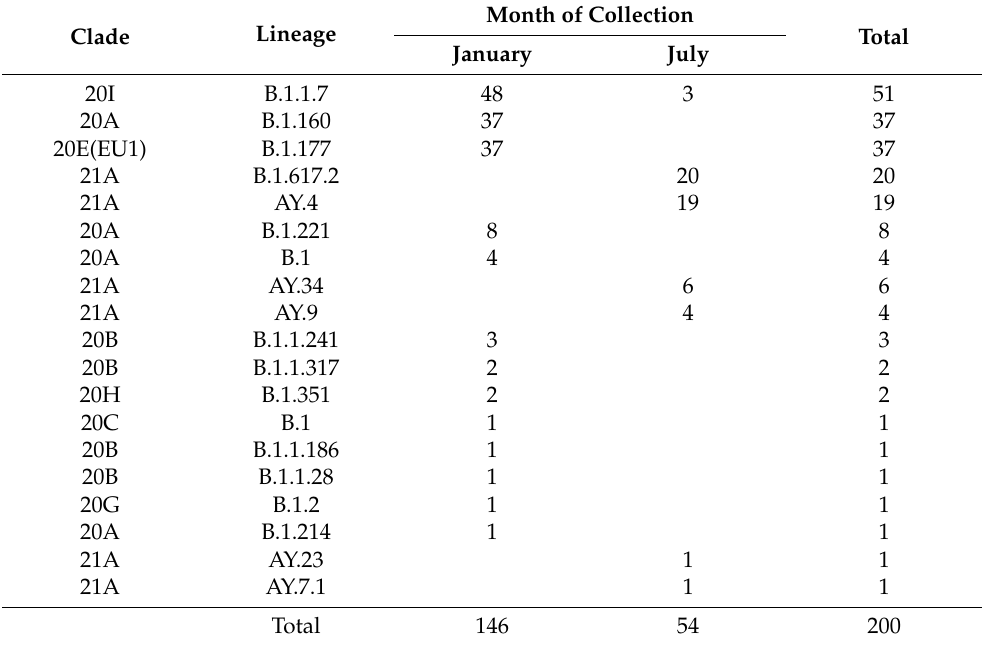
Table 2. Sample lineages and